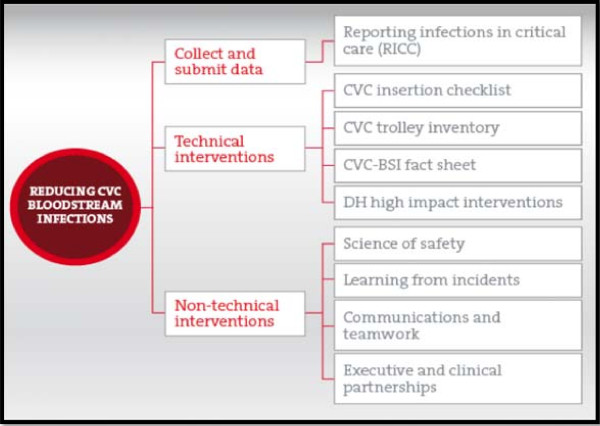
Matching Michigan.